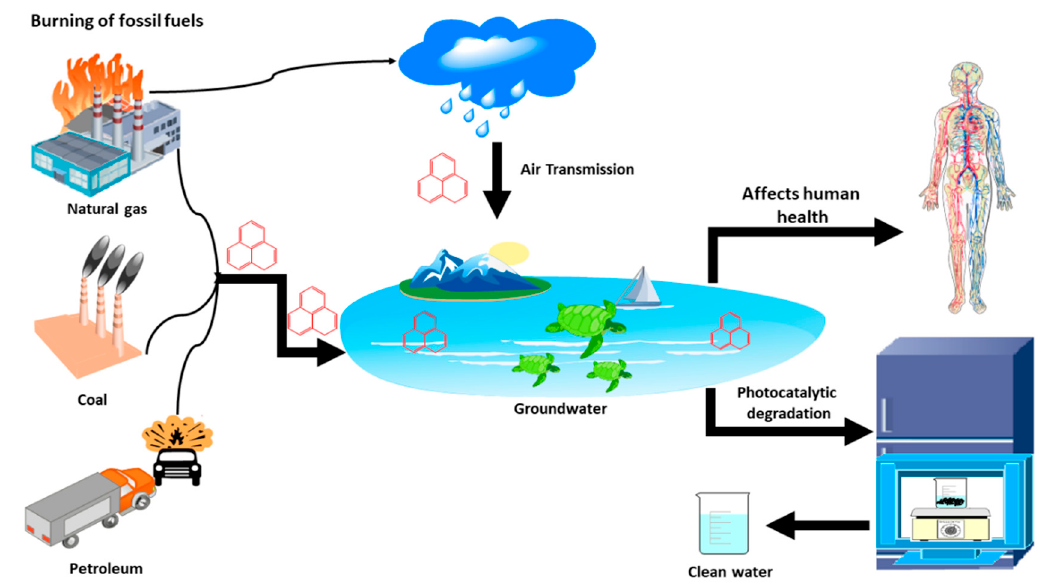
Figure 1. Schematic representation of environmental remediation of phenanthrene by photocatalysis.